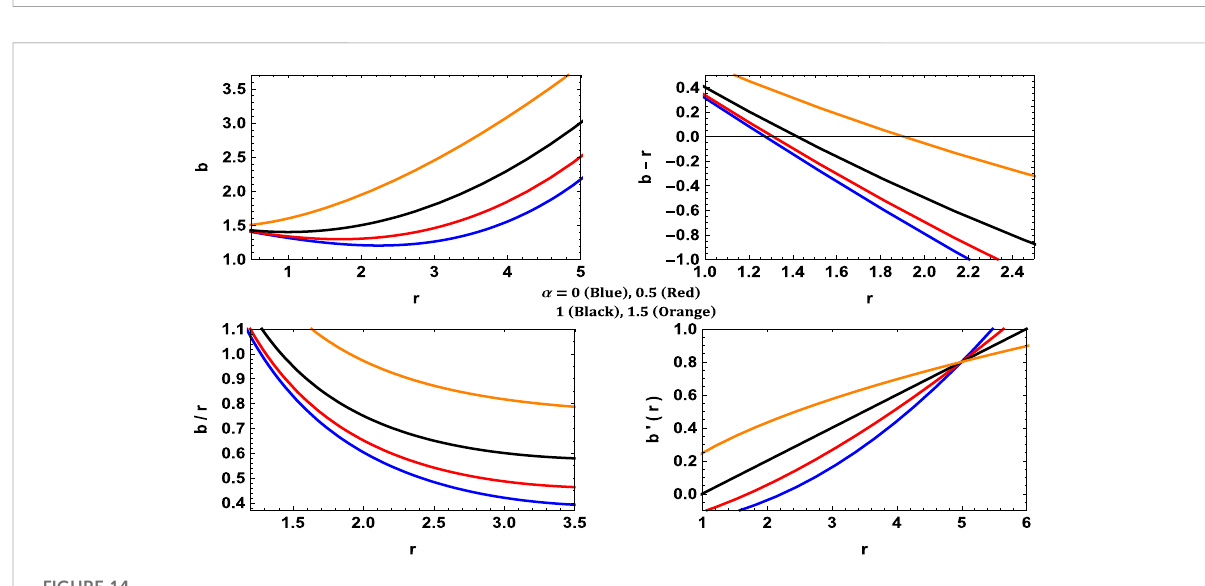
FIGURE 14 Variation of b , b − 2, b / r and b ′ ( r ) for model VI with c = 0.04, λ = 1.2, F = 1.5, a = 5, ω = −